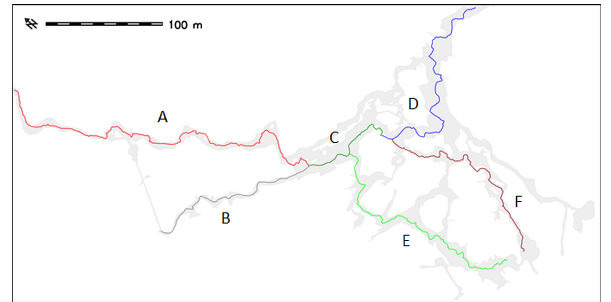
Figure 7. Segments of ceiling lines with assigned letters as refer- enced in the text and as reported in Table